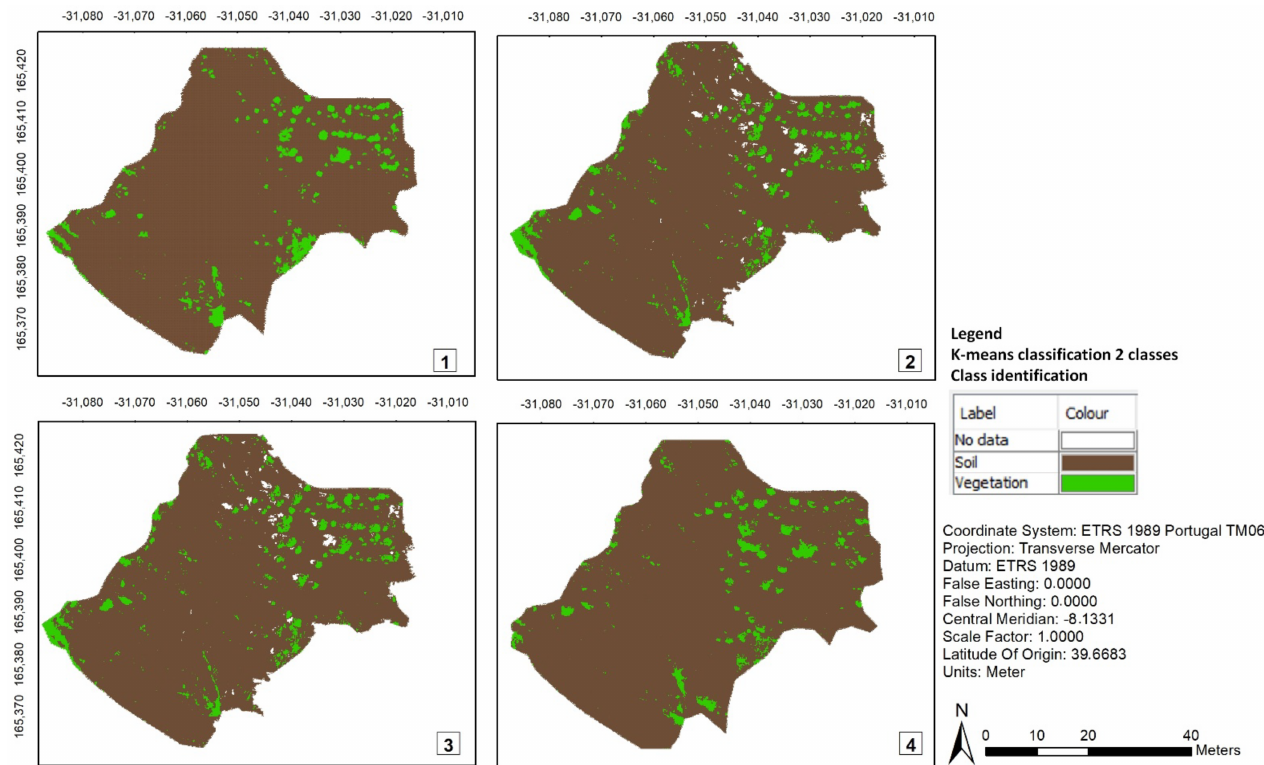
Figure 10. Unsupervised classification considering the k-means algorithm: RGBNIR composition (1—July 2019;